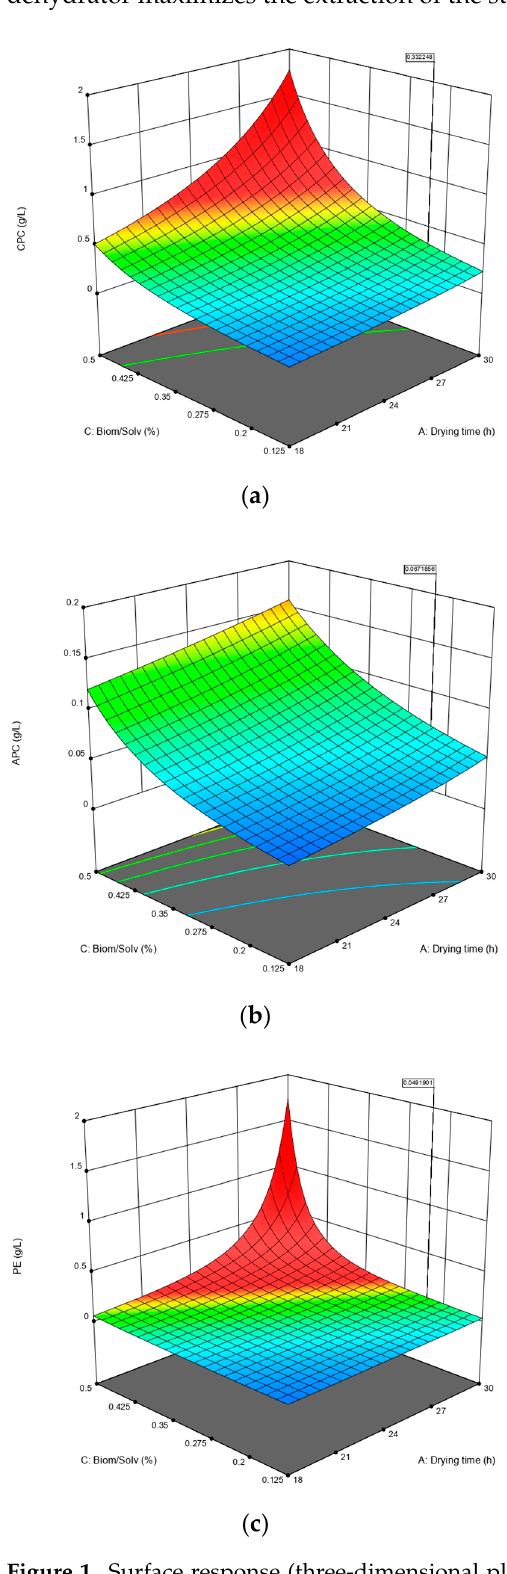
Figure 1. Surface response (three-dimensional plots) of the model equation fitted to the data on extraction concentration (g/L) of C-PC ( a ), APC ( b ), and PE ( c ).